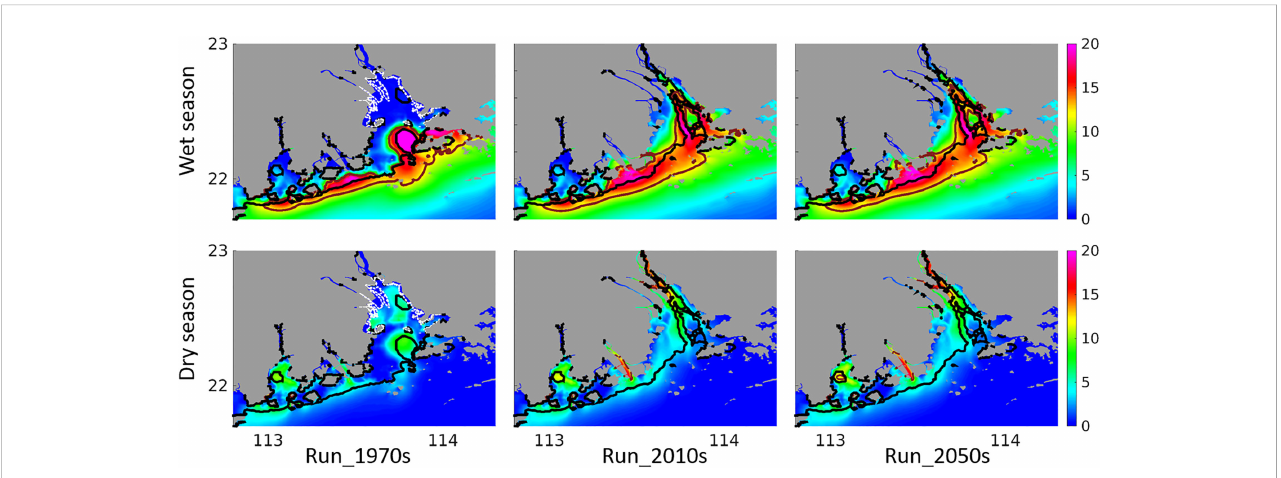
FIGURE 3 The salinity difference from bottom to surface in wet and dry season of Run_1970s, run_2010s and Run_2050s, areas with salinity difference values greater than 12 psu is surrounded by brown lines. The black line indicates the 7-m isobath. The white dashed line in the Run_1970s refers to the location of coastline in 2010s. (Unit: